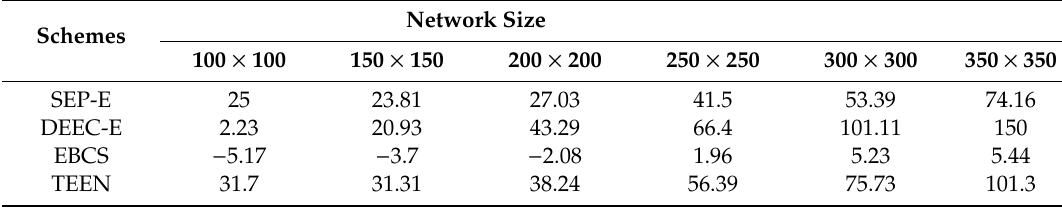
Table 10. Percentage Improvement of HFECS in terms of half-life